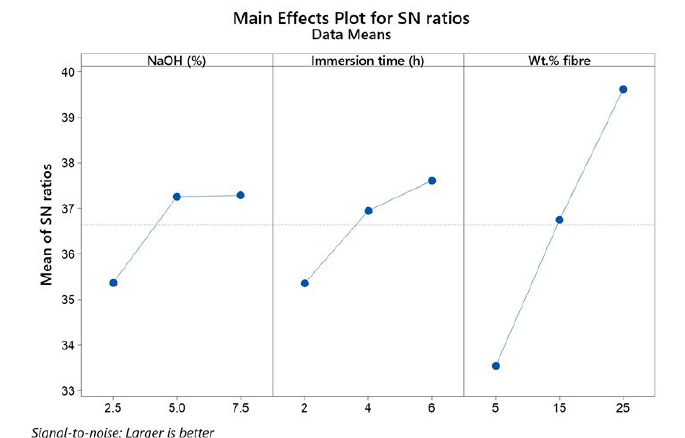
Figure 8. Main effect plots for the mean S/N ratios of tensile strength.